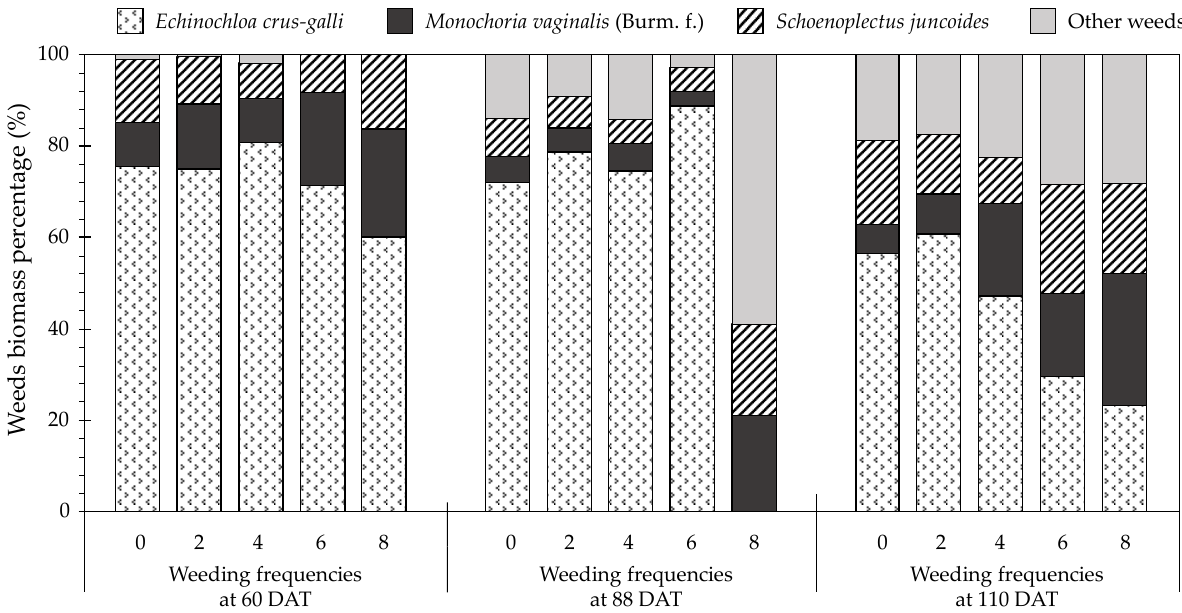
Figure 3. Effect of weeding frequencies on weed biomass percentage at 60, 88, and 110 DAT (days after transplantation). The frequency of mechanical weeding until 49 DAT was 0, 2, 4, 6, and 8 times.